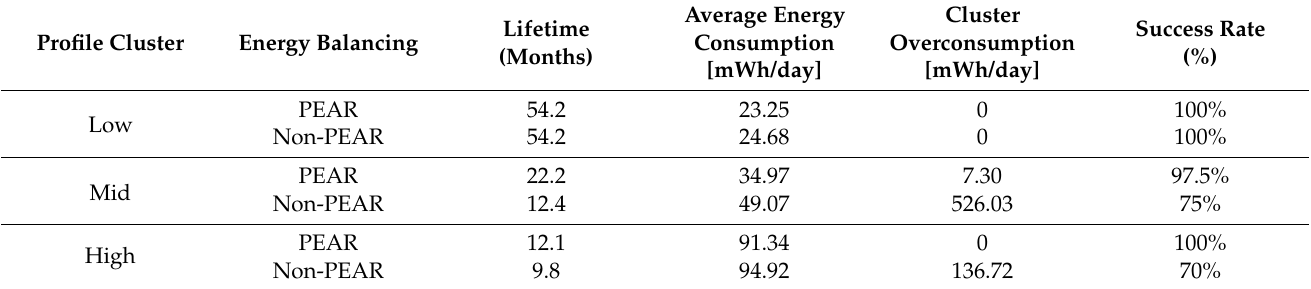
Table 7. The comparison between the PEAR and Non-PEAR for the three profile cluster